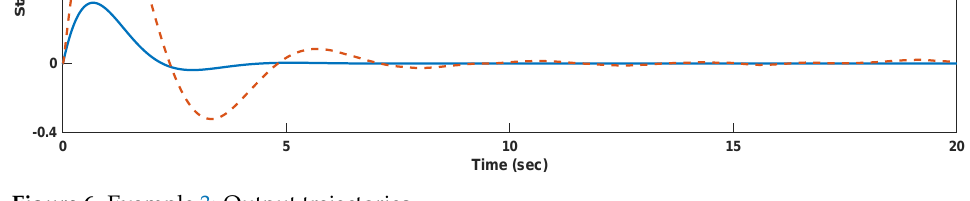
Figure 6. Example 3: Output trajectories.